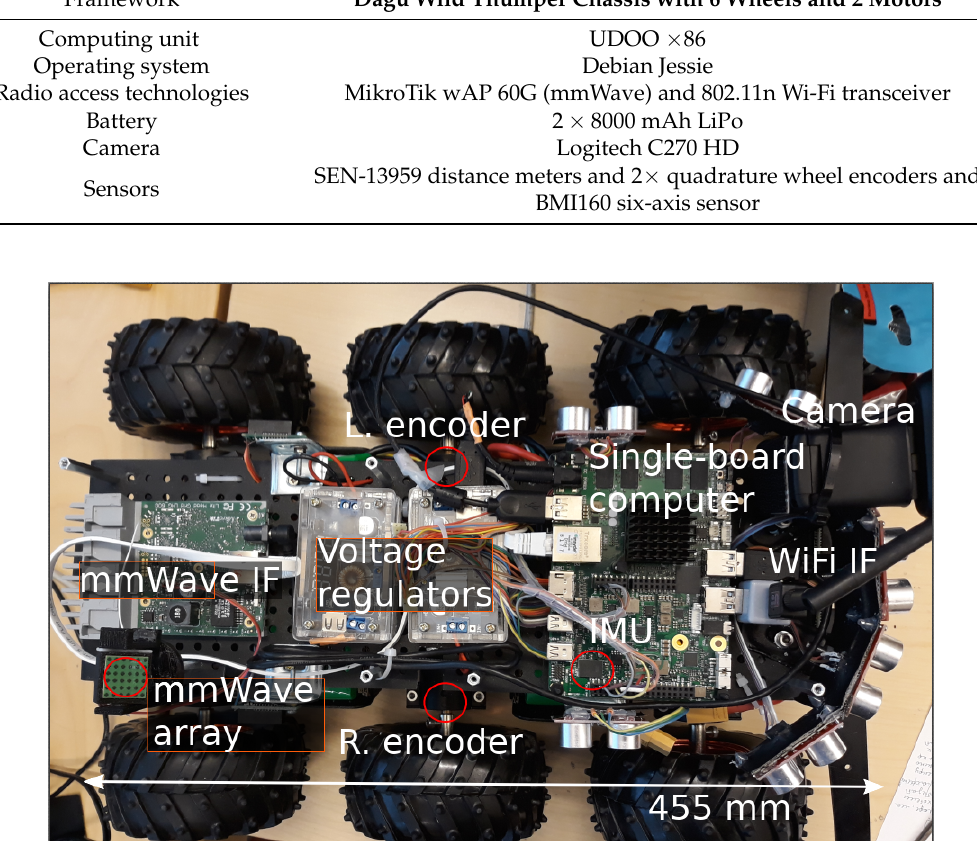
Figure 2. Prototype photo (disassembled) with